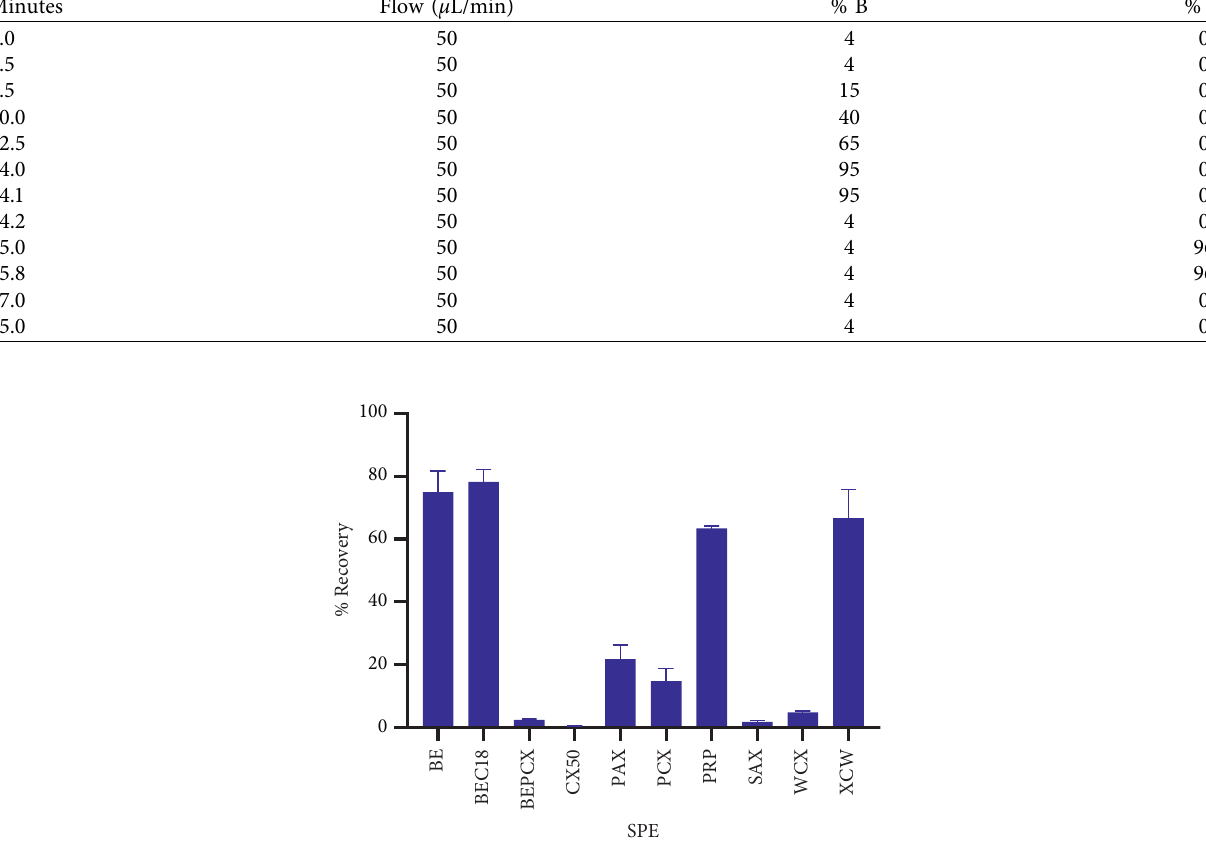
13 C 6 -dabigatran (b). 6 -carbon atoms in the internal standard are indicated as red dots